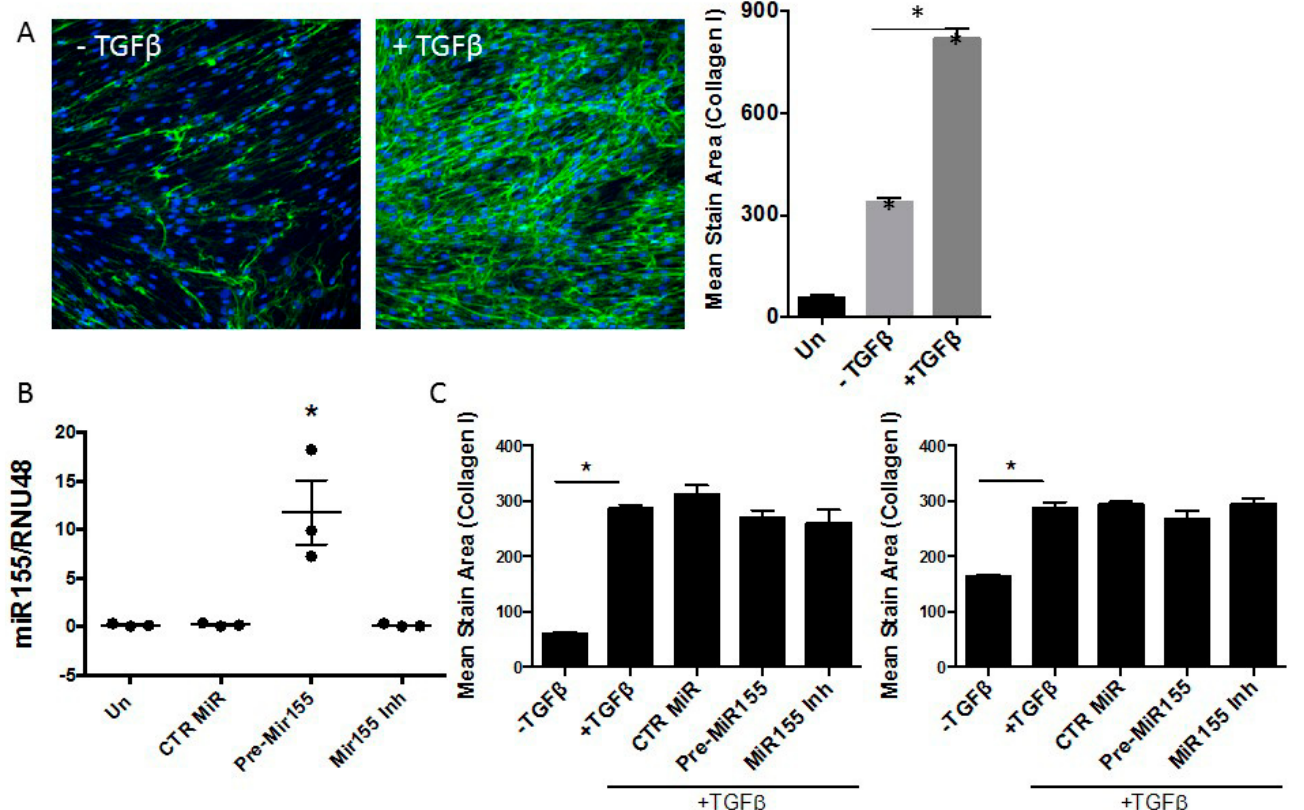
Figure 4. miR155 overexpression does not alter TGF β -induced collagen deposition in vitro. ( A ) Using the in vitro scar-in-a-jar model, enhanced collagen deposition was detected by primary human lung fibroblasts cultured with 1 ng/mL of TGF β in the presence of ficoll and L-ascorbate for 48 h. Collagen deposition was quantified at × 20 magnification using ImageXpress and is represented as mean stain area ± SEM, n ≥ 5. ( B ) miR155 levels were significantly increased in pre-miR155-transfected lung fibroblasts. PCR data from three individual primary lung fibroblast cultures are shown. ( C ) Quantitative analysis of collagen deposition in two individual primary lung fibroblast cultures transfected with either control precursor miR (CTR MiR), precursor to miR155 (pre-miR155) or a miR155 inhibitor (miR155 Inh). No significant difference was detected in pre-miR155 transfected or TGF β only groups, suggesting that miR155 overexpression does not affect TGF β -induced collagen deposition in this model. * P < 0.05.